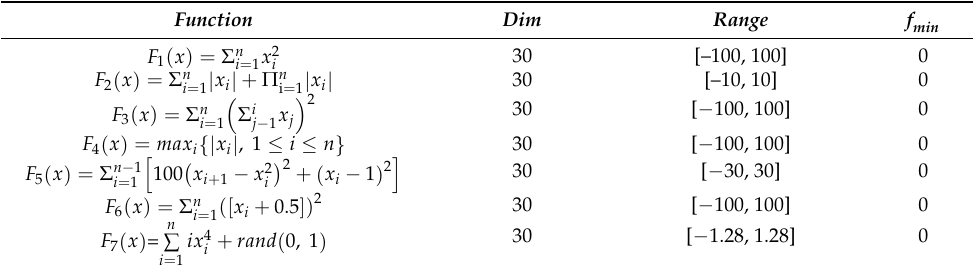
Table 1. Description of unimodal benchmark functions ( F 1 – F 7 ).